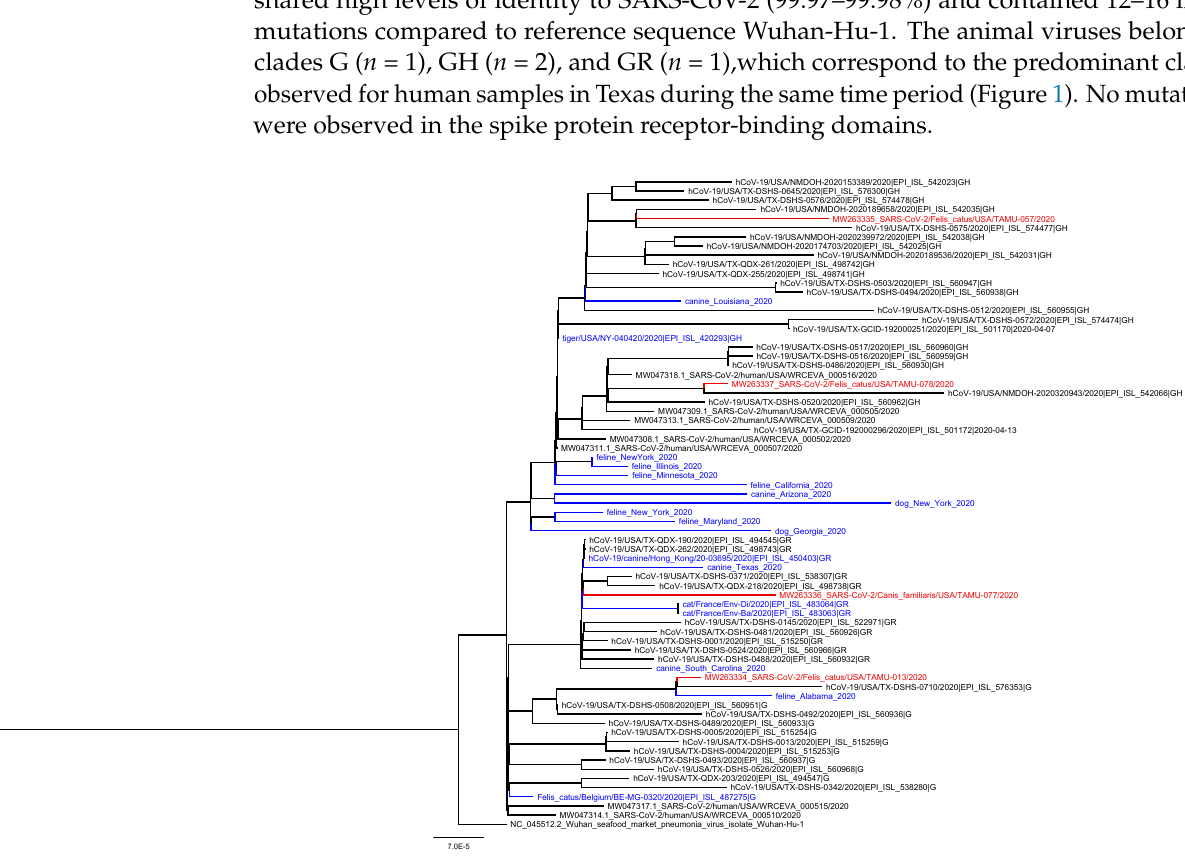
Table 3. Pets with SARS ‐ CoV ‐ 2 neutralizing antibody titers from households with at least one confirmed case of human COVID ‐ 19 in Brazos County, Texas, at first (A) and subsequent (B–D) sampling visits from June ‐ September, 2020. All households with at least one VN ‐ positive animal are shown, with all animals living in the household tested one or more times. For the column of PCR results, any positive PCR result in any of the screening or confirmatory assays is considered positive.